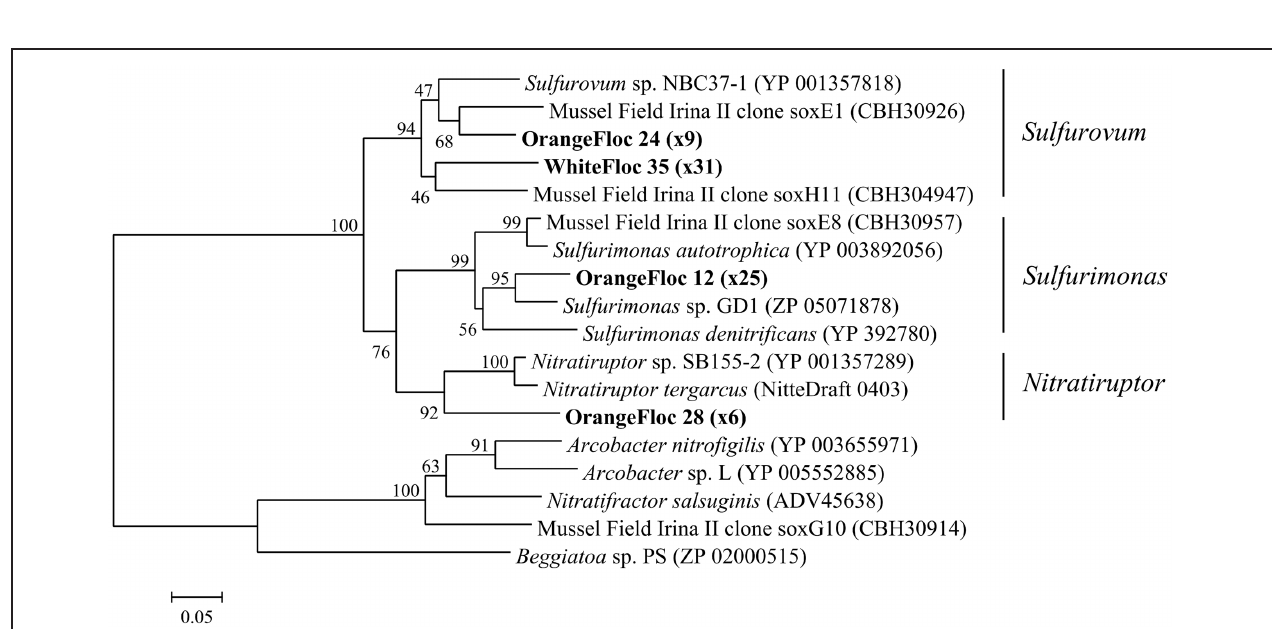
computed using the Poisson correction method and are shown in units of the number of amino acid substitutions per site. Sequences obtained in this study are highlighted in bold. The number of replicate clones is shown in